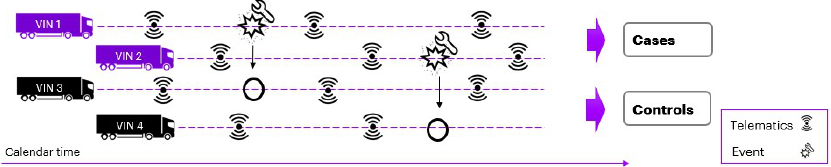
Figure 4. Case-control